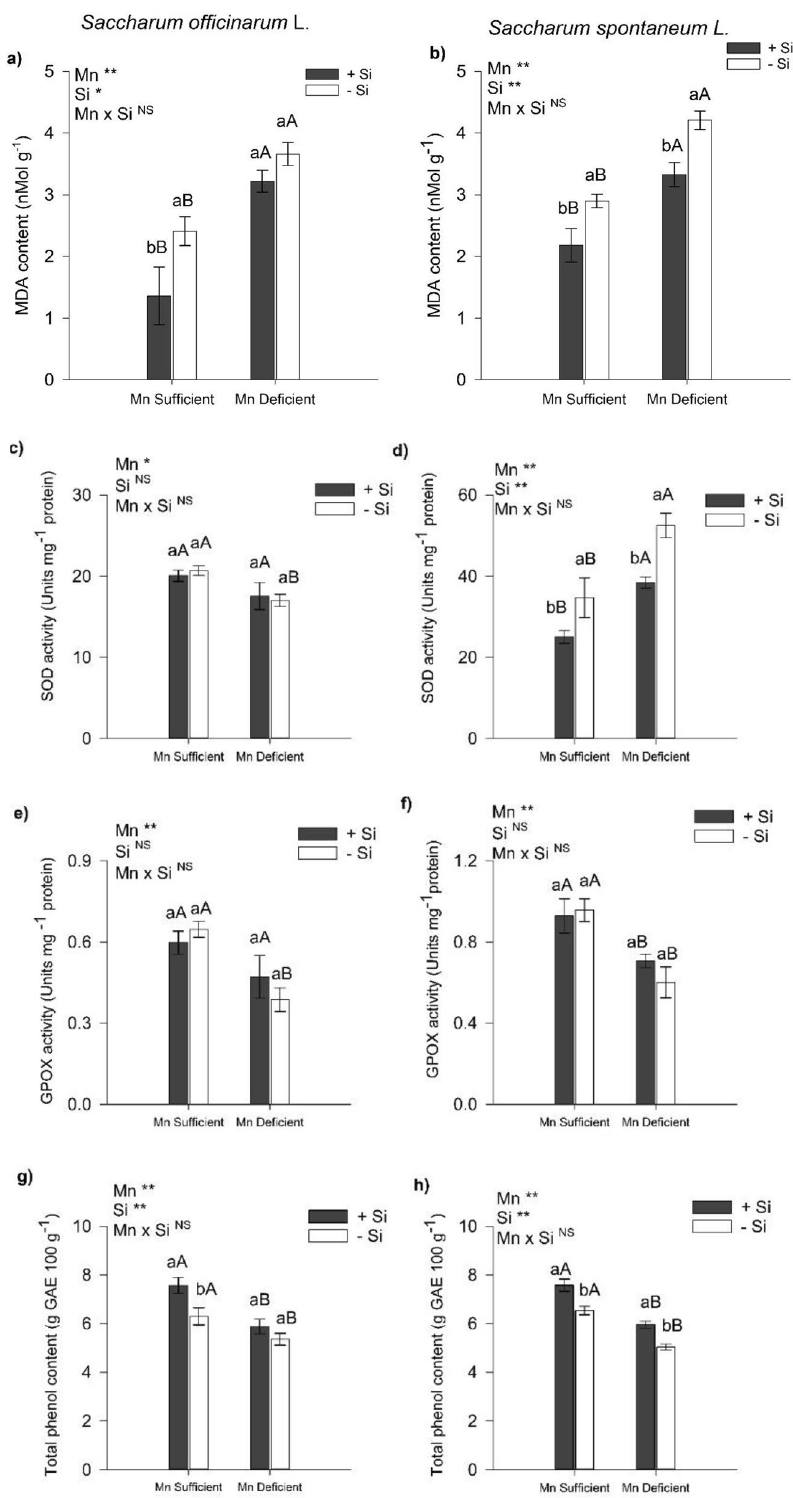
Figure 2. MDA content ( a , b ), superoxide dismutase (SOD) activity ( c , d ), guaiacol peroxidase (GPOX) activity ( e , f ), and total phenol content ( g , h ) of leaves of sugarcane ( Saccharum officinarum L.) and energy cane ( Saccharum spontaneum L.) plants, respectively, grown in Mn-sufficient and deficient nutrient solution in the absence (− Si) and presence (+ Si) of Si. F-test was applied: * ( p ≤ 0.05); **( p ≤ 0.01), and ns not significant. Different lowercase letters compare Si conditions under the same Mn condition ( p < 0.05 by Tukey test), while different uppercase letters compare Mn conditions under the same Si condition ( p < 0.05 by Tukey test). Bars represent the mean standard error, n =